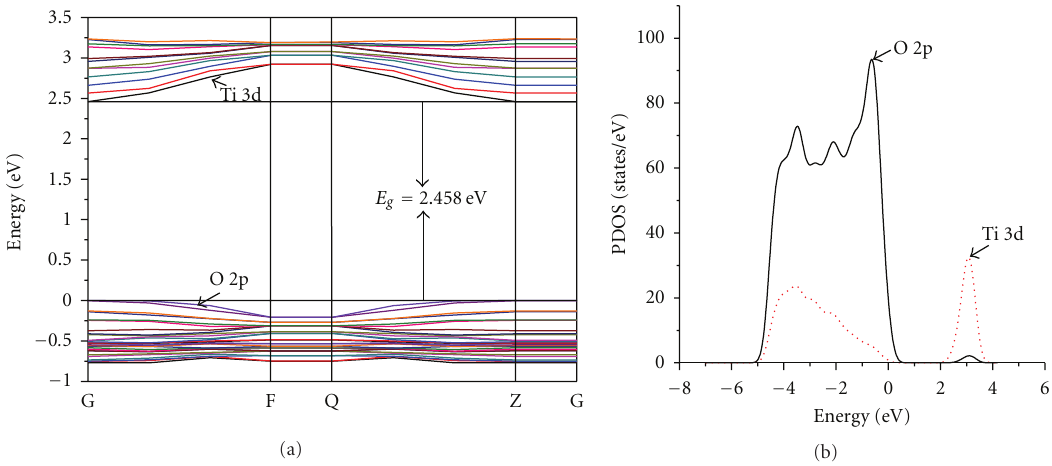
Figure 7: Ti 32 O 64 : (a) band structure, (b) partial density of state.